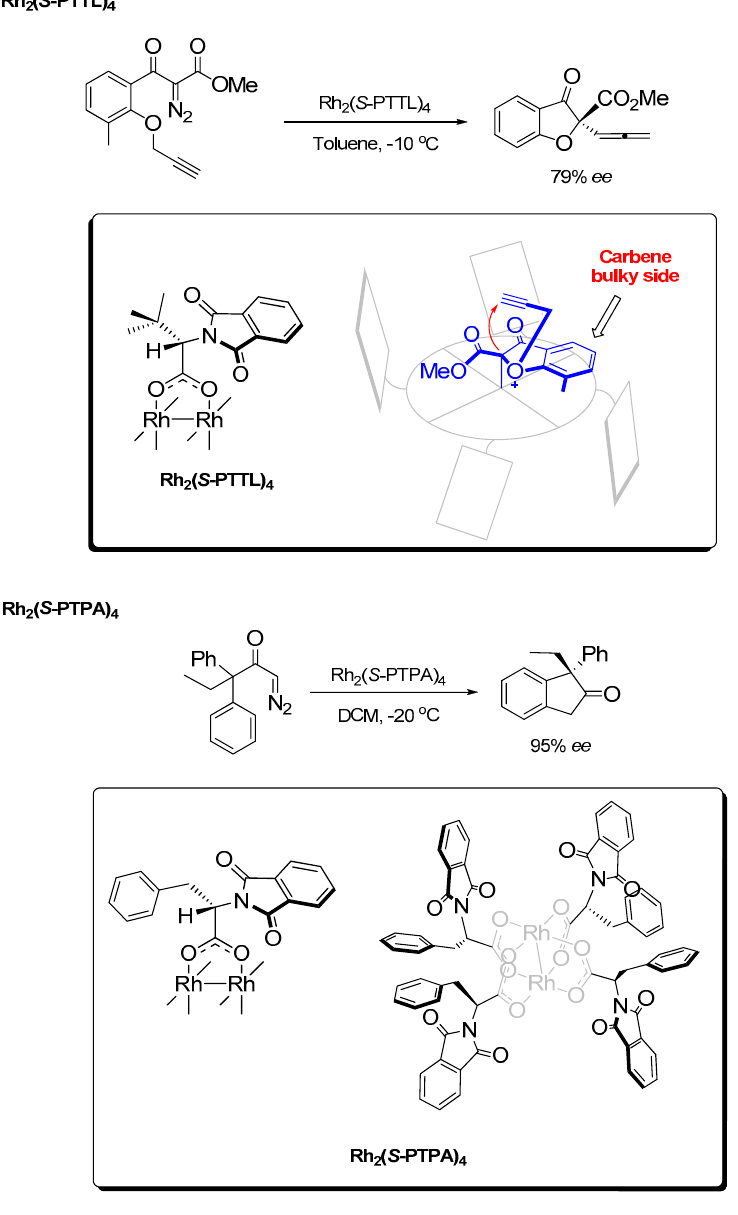
( a ) Rh 2 ( S -PTTL) 4 -catalyzed enantioselective tandem propargylic oxonium ylide formation/[2,3]-sigmatropic rearrangement (Facial selectivity of the Rh 2 ( S -PTTL) 4 -stabilized carbene according to the model proposed by Hashimoto et al. [85]); ( b ) Rh 2 ( S -PTPA) 4 -catalyzed